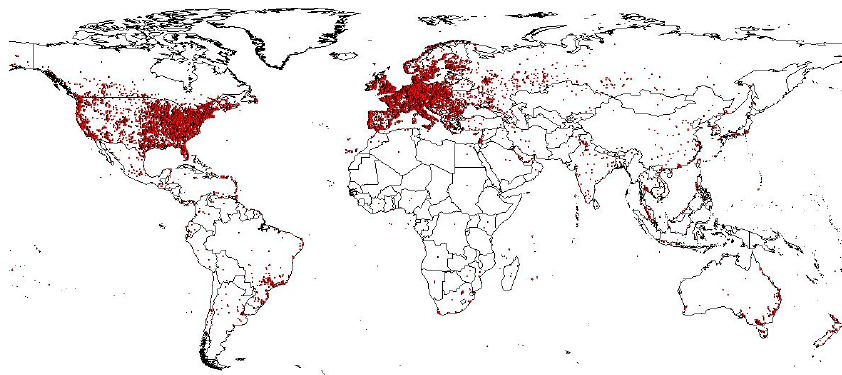
Figure 13. Global Distribution of Geo-located Internet Protocol (IP) Nodes.